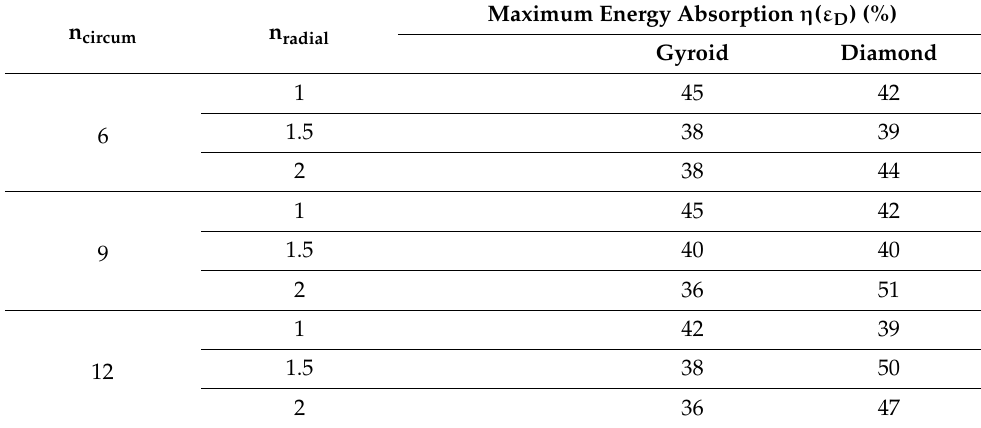
Table 7. Comparison of maximum energy absorption for Gyroid and Diamond TPMS cylindrical structures. n circum n radial